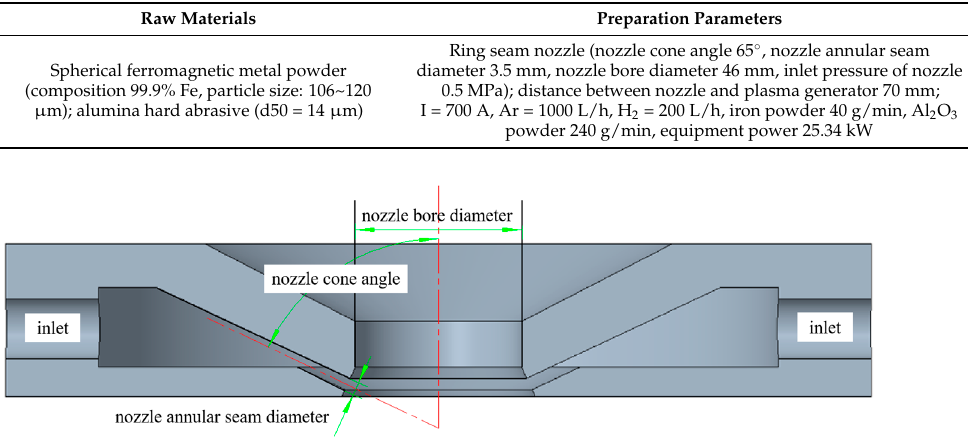
Table 1. Preparation of raw materials and preparation parameters.